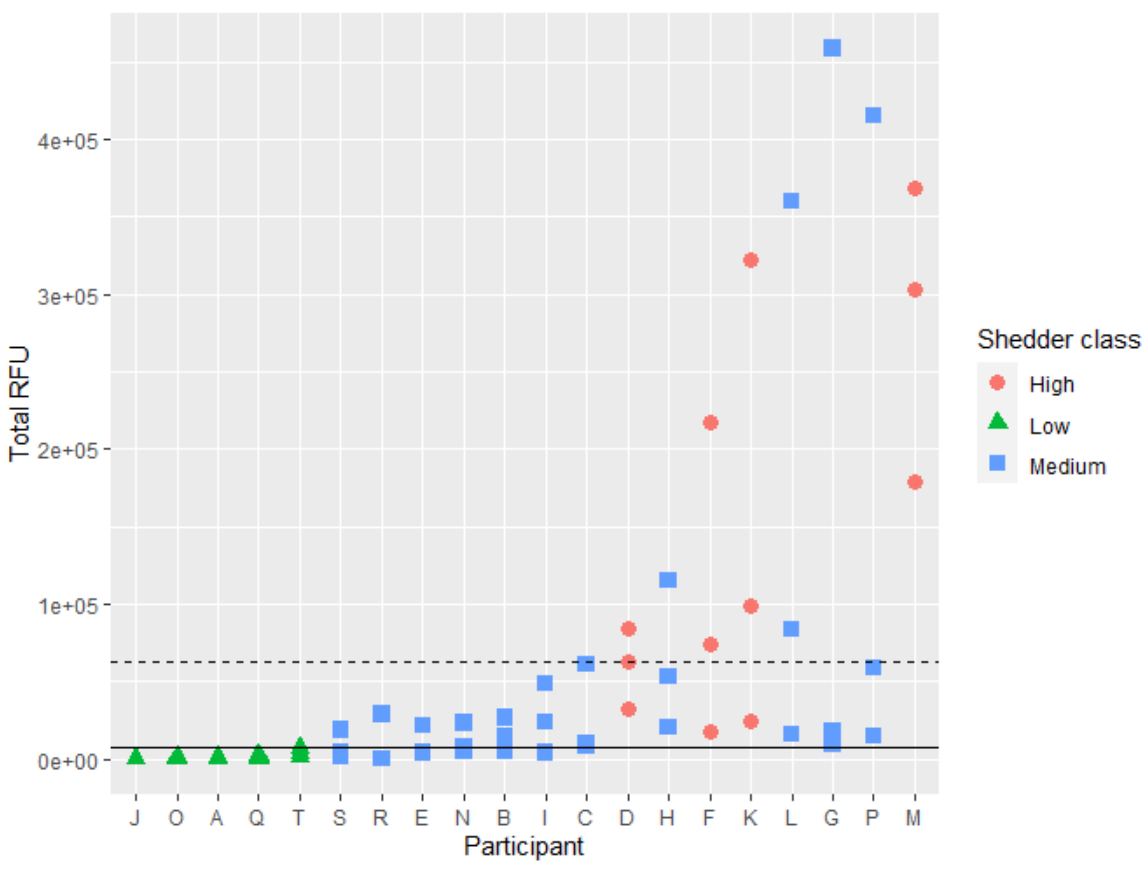
Figure 4. Scatter plot showing the total RFU tot values (multiplied by M x if sample was a mixture) for each sample collected from each participant and according to their shedder status, high (red circle), medium (blue square) low (green triangle). The average RFU tot (6.25E+04) and low shedder limit of 8.00E+03 RFU tot are represented with the dotted and straight lines, respectively.